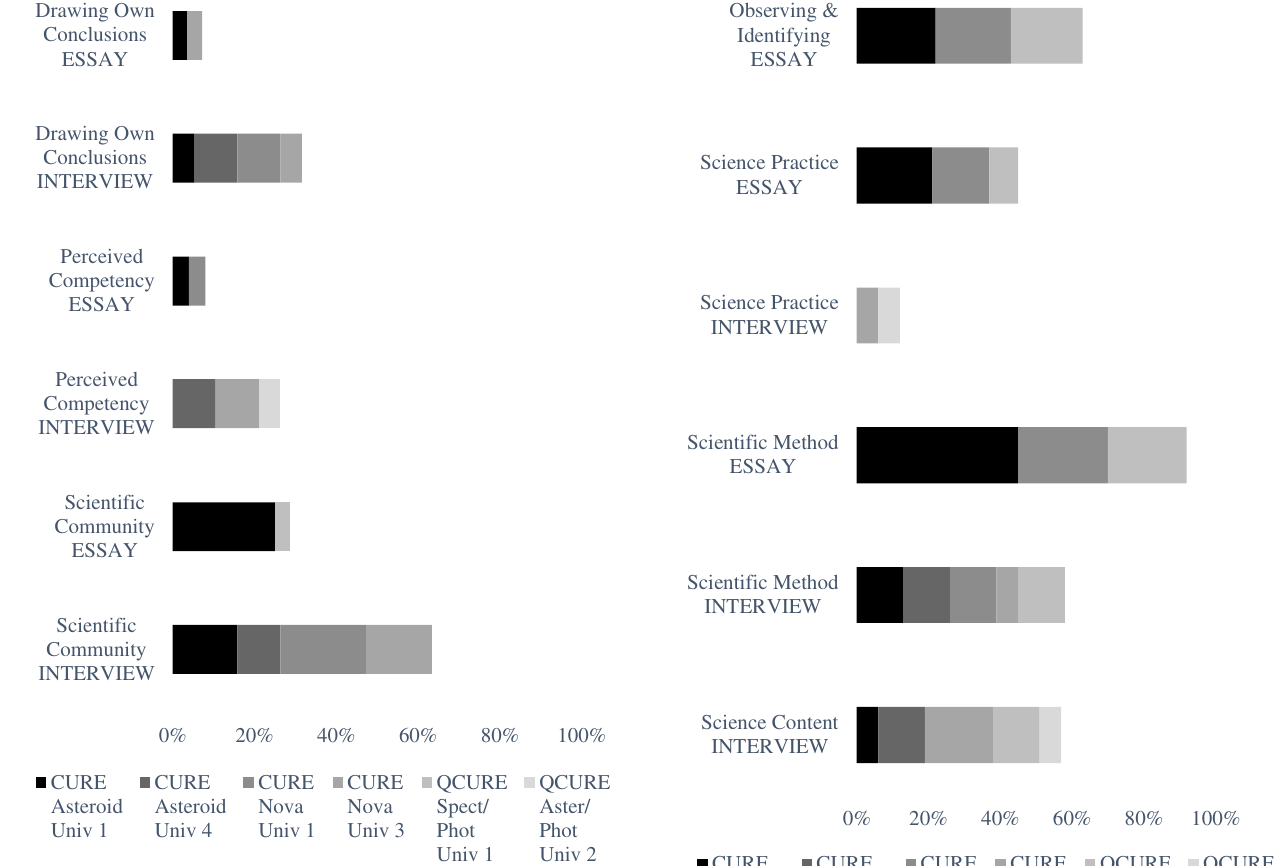
Table I. Example quotes from the categories and themes emergent from the qualitative analysis are presented in Tables III – VII. The percentage of student responses coded as mentioning each theme are presented in Figs. 4 – 7.